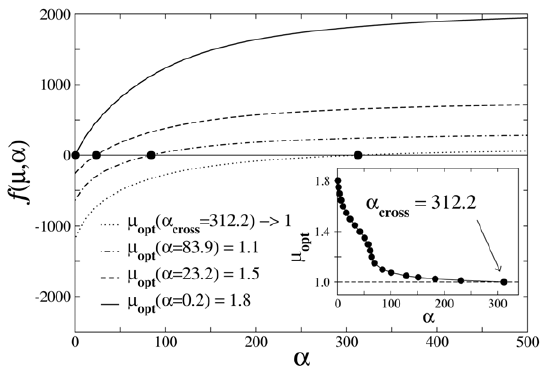
Figure 4. Determination of the optimal search strategy of Le´vy random searchers with Poissonian fluctuations in the distances to nearby targets, Eq. (4). The condition f ( m ~ m opt , a ) ~ ~ 0 , for l ~ 10 3 and r ~ 1 , provides the optimal Le´vy LS L T p = L m j v m ~ m opt exponent, m opt , associated with the strategy of maximum average efficiency. Inset: since strategies with m ƒ 1 are not allowed (non- normalizable pdf of step lengths), the highest efficiency is always obtained for m ? 1 as fluctuations with a w a cross & 312 : 2 are considered, marking the onset of a regime dominated by ballistic optimal search